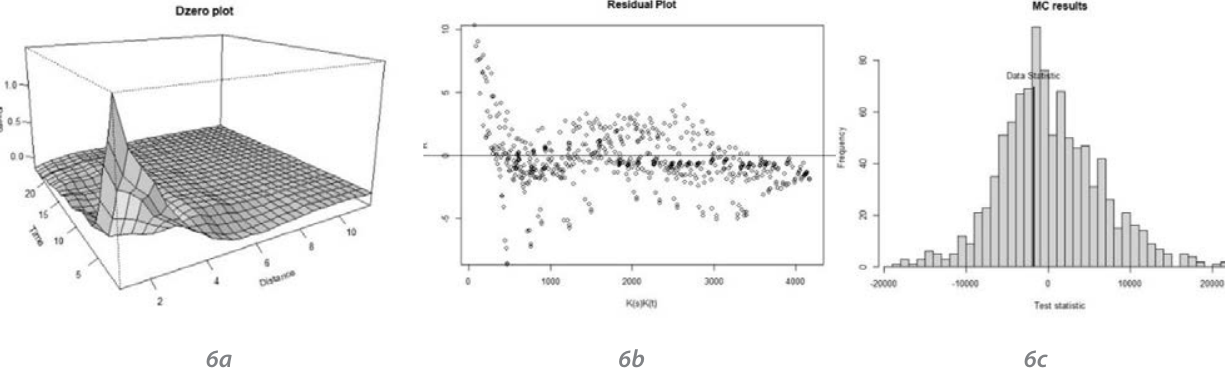
Figure 6: Diagnostic plots for space-time clustering at year scale (a: the perspective plot of the difference between spatiotemporal K-function and the product of the spatial and temporal K-functions; b: the standardised residuals against the product of the spatial and temporal K-functions (middle) and c: histogram of the test statistics, where the statistic for the data is indicated with a vertical